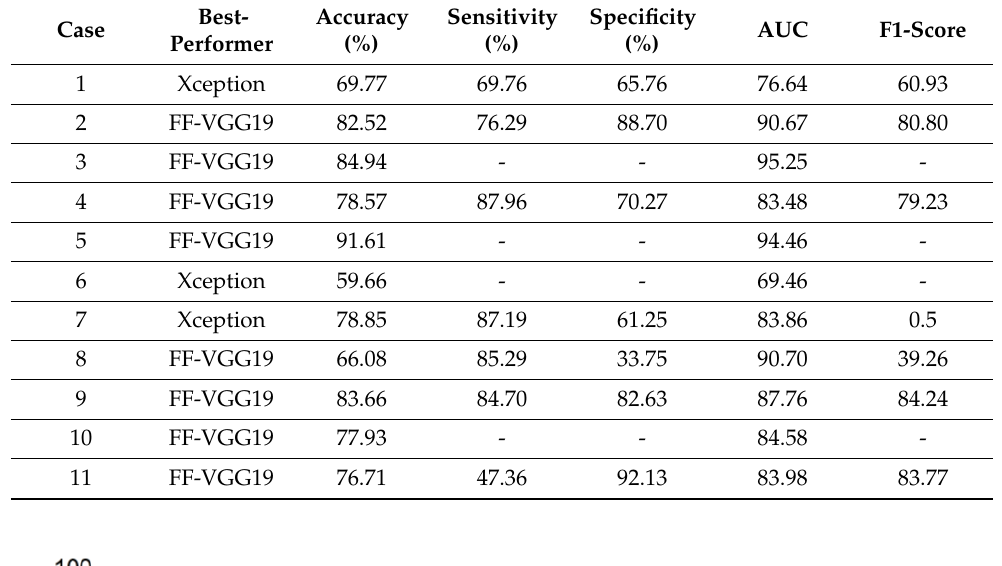
Table 8. Classification metrics of the best CNN for each dataset when training from scratch.